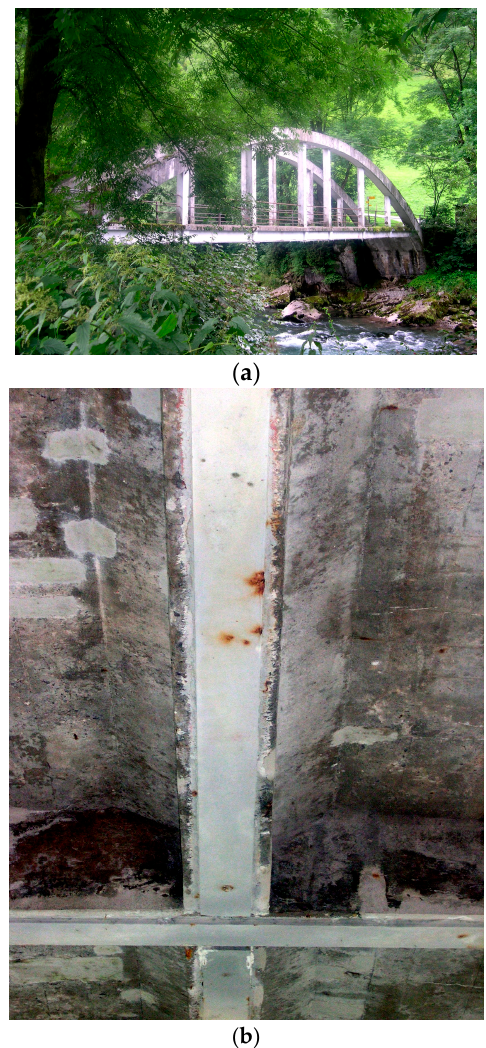
Figure 3. ( a ) Gizenenbridge in Switzerland and ( b ) bottom side of the bridge with steel plates (both photos in the year 2005).